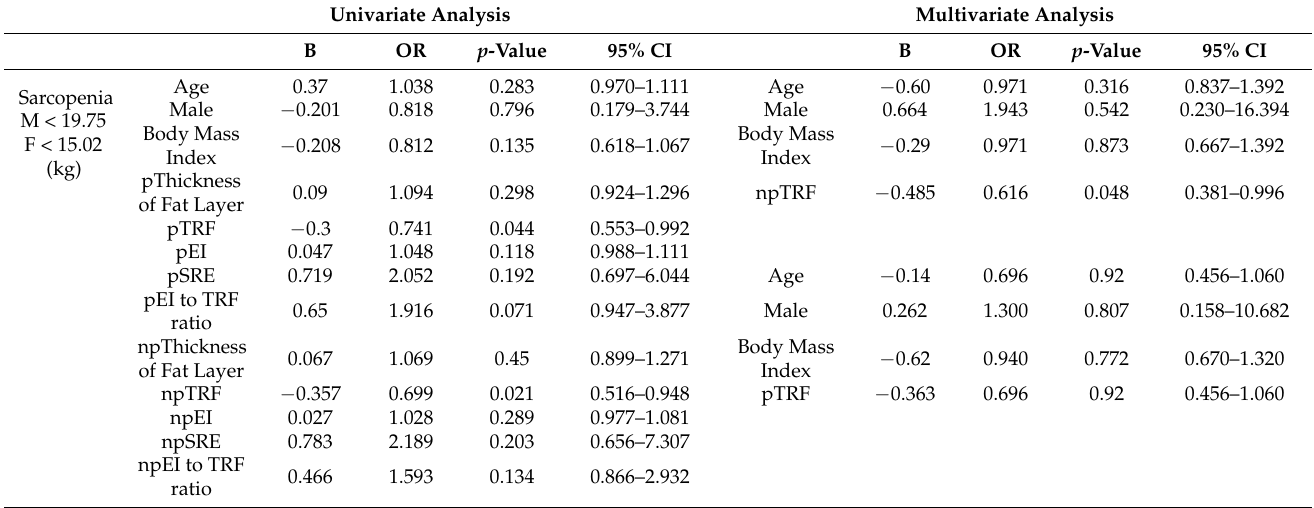
Table 4. Risk factor of US measurements according to sarcopenia. Univariate